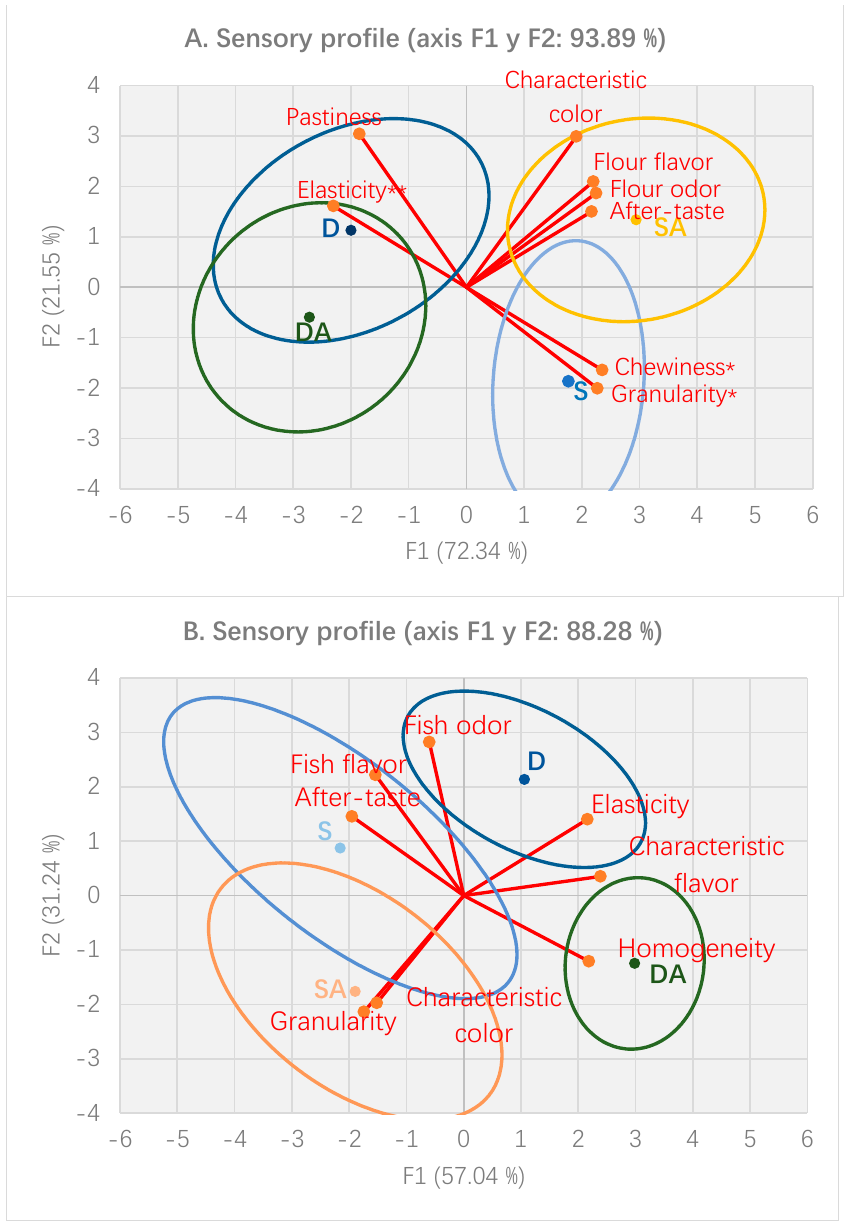
Figure 6. ( A ) Sensory profile at day 0 and ( B ) Sensory profile at day 90 from square cosines provided by sensory trained assessors valuations. D: Durum F, DA: Durum F + antioxidant, S: Spelt F, SA: Spelt F + antioxidant. * Attribute showed significant differences (p < 0.05). ** Atribute showed significant differences ( p < 0.01)